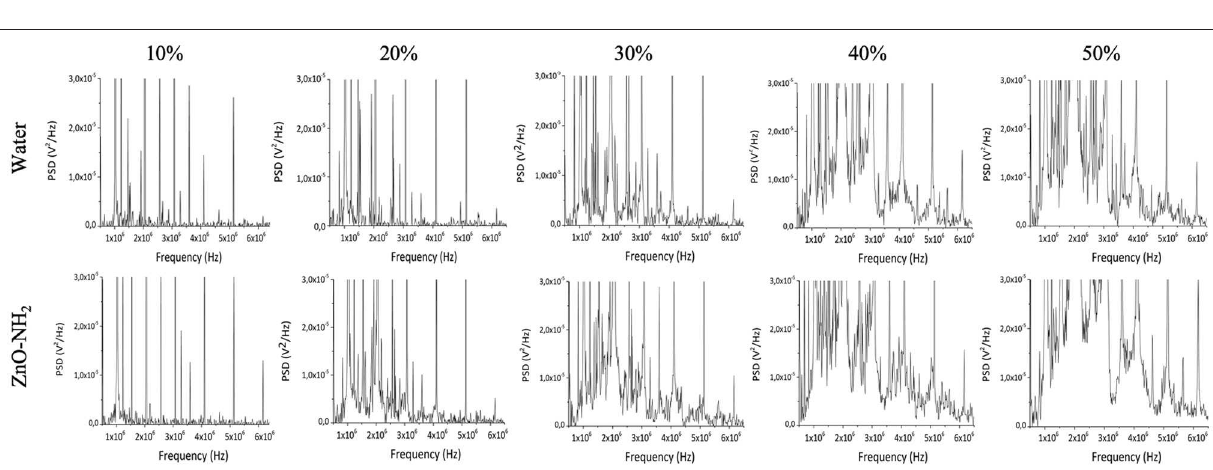
FIGURE 5 | Frequency spectra recorded by needle cavitometer in order to evaluate cavitation of water and ZnO-NH 2 NCs water suspensions. The comparison between the two solutions was carried out at 1 MHz, 100% of DC, 10min of insonation with 0.3, 0.6, 0.9, 1.2, and 1.5 W/cm 2 , which correspond to 10, 20, 30, 40, and 50% of maximum available US